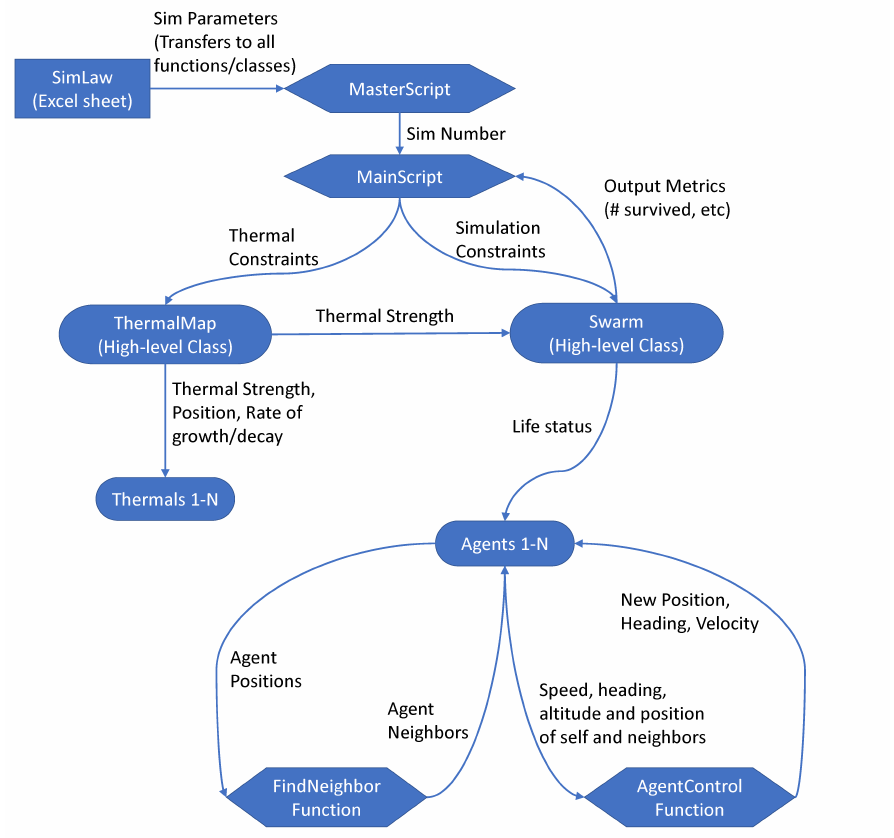
Figure 1. Flowchart of the simulation methodology including high-level scripts, simulation parame- ters, and intermediary